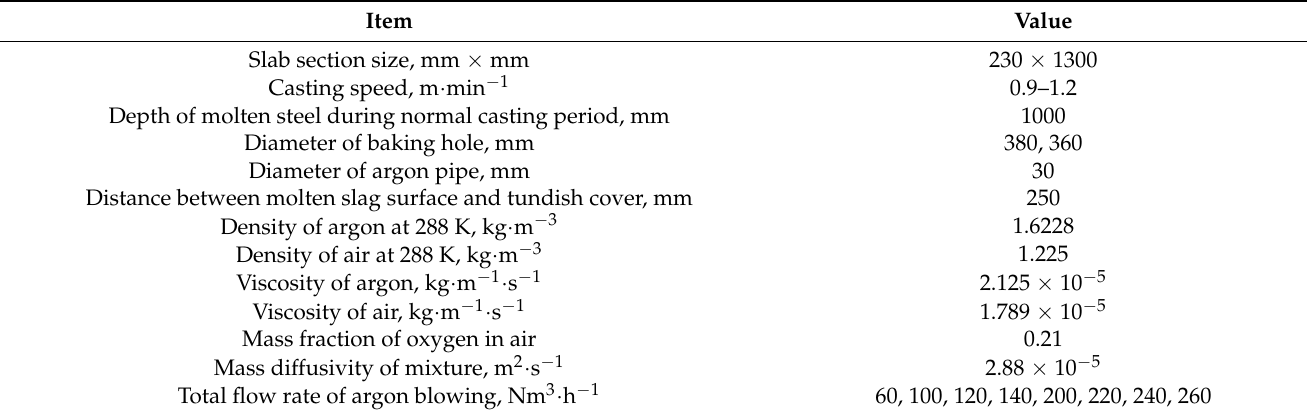
Table 1. Parameters of tundish and the casting process.